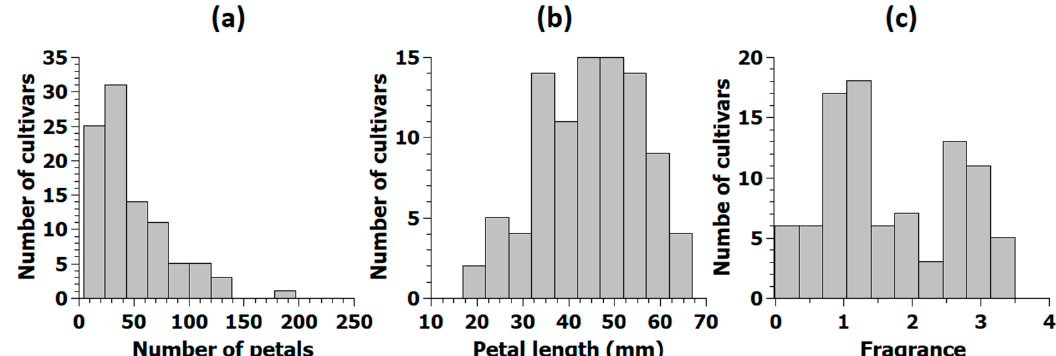
Figure 1. Distribution of the mean for petal number ( a ), petal length ( b ) and of the median for fragrance ( c ) in the association panel. Normal distribution was tested with Shapiro-Wilk for petal number ( p = 0.29), petal length ( p = 2.9 × 10 − 7 ) and fragrance ( p = 2.6 × 10 − 5 ). Fragrance score: 0 = no fragrance, 1 = mild to moderate fragrance, 2 = good fragrance, 3 = strong fragrance, and 4 = very strong fragrance.